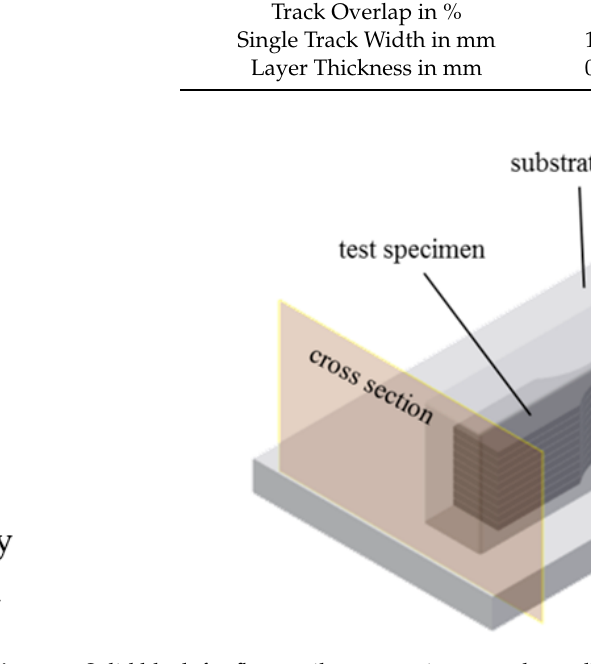
Figure 5. Solid block for flat tensile test specimens and metallographic witness sample.